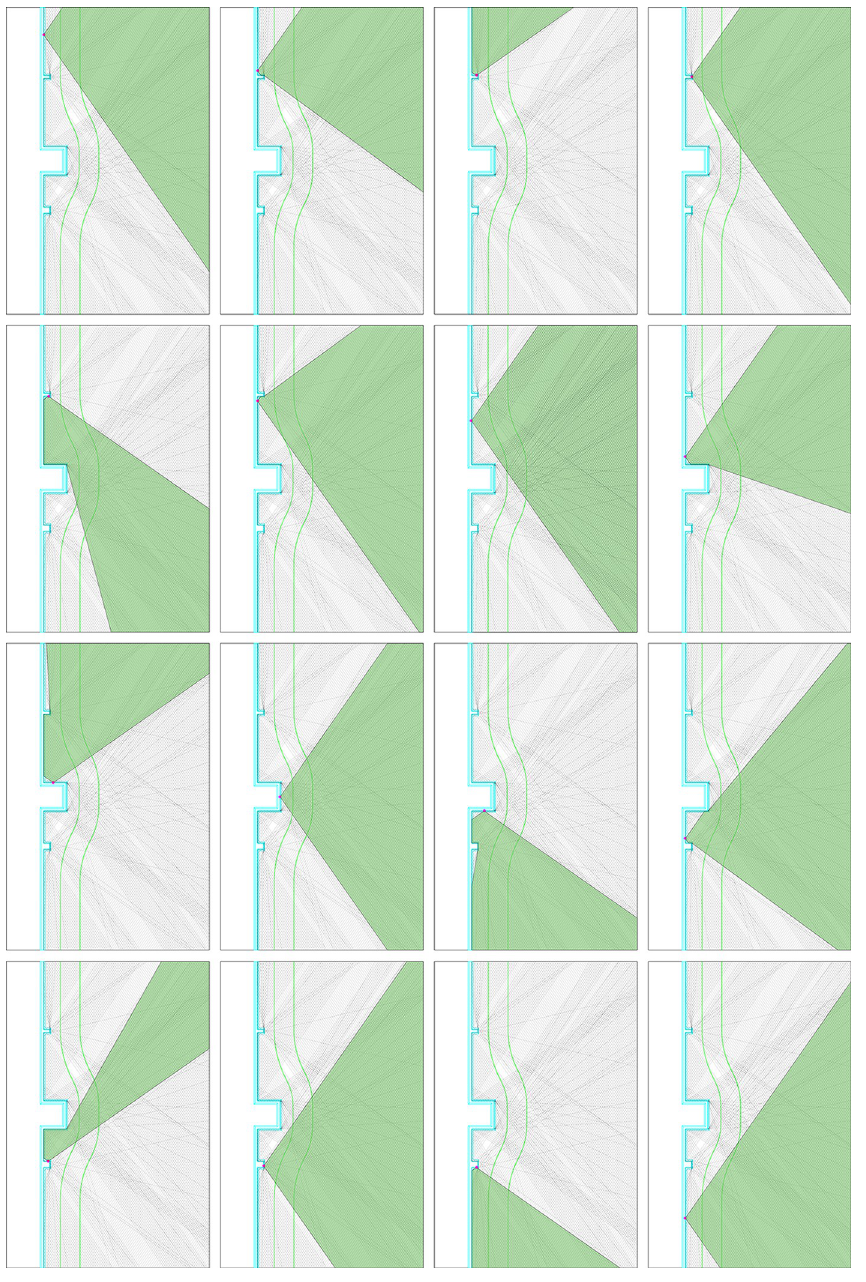
Fig 7. The firing range at different points of the